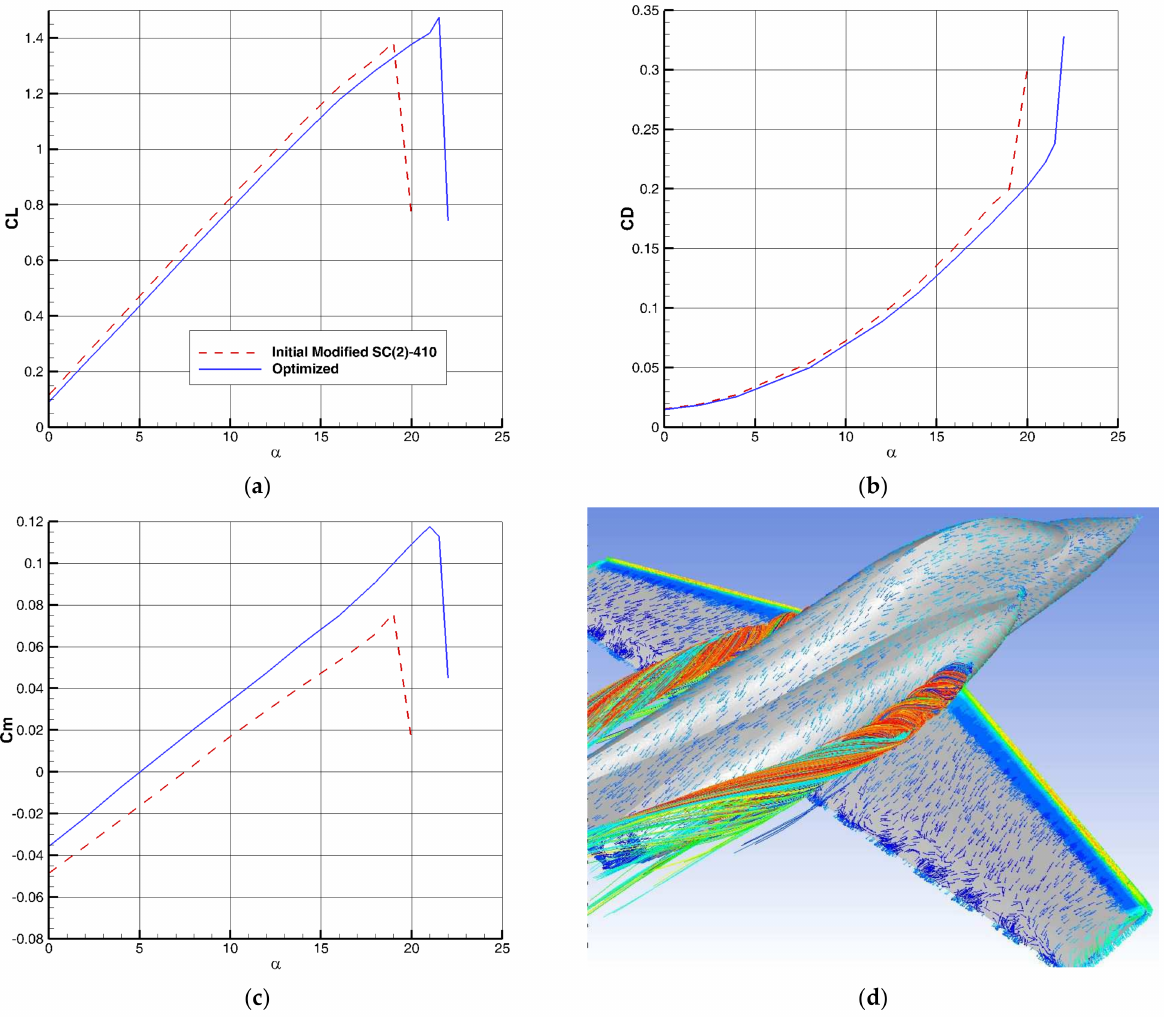
Figure 13. Comparison of the initial and optimized airfoil of wing-body in the presence of PVG in V = 60 m/s: ( a ) C L − α diagram; ( b ) C D − α diagram; ( c ) C m − α diagram; ( d ) the path lines of PVG and wing-body vectors at α = 21 ◦